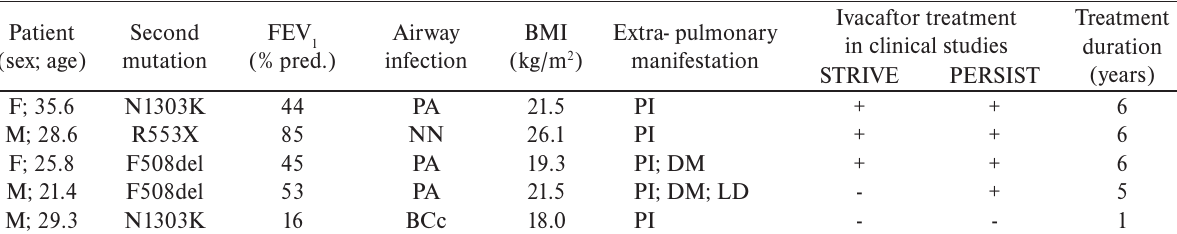
Table 1. Characteristic of patients.